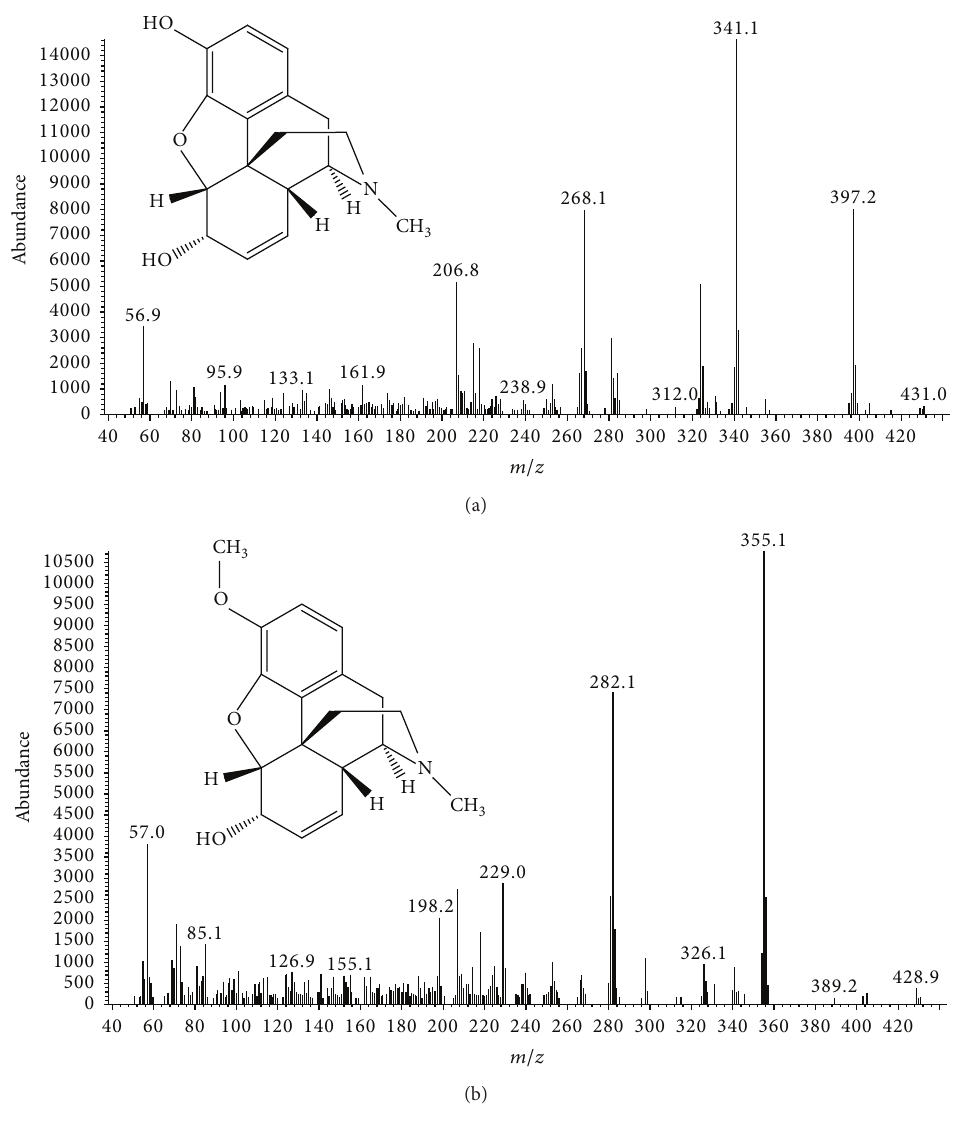
Figure 1: Mass spectra of morphine (a) and codeine (b) in SIM mode with EI (+)